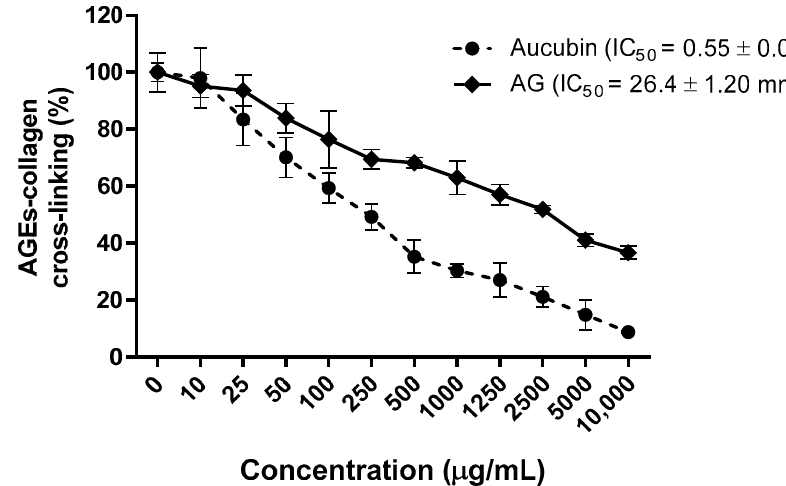
Figure 2. Inhibitory effect of aucubin and AG on the cross-links of AGEs with collagen in vitro. All results are expressed as the mean ± SE, n = 4. The IC 50 values were determined from the plotted graph.